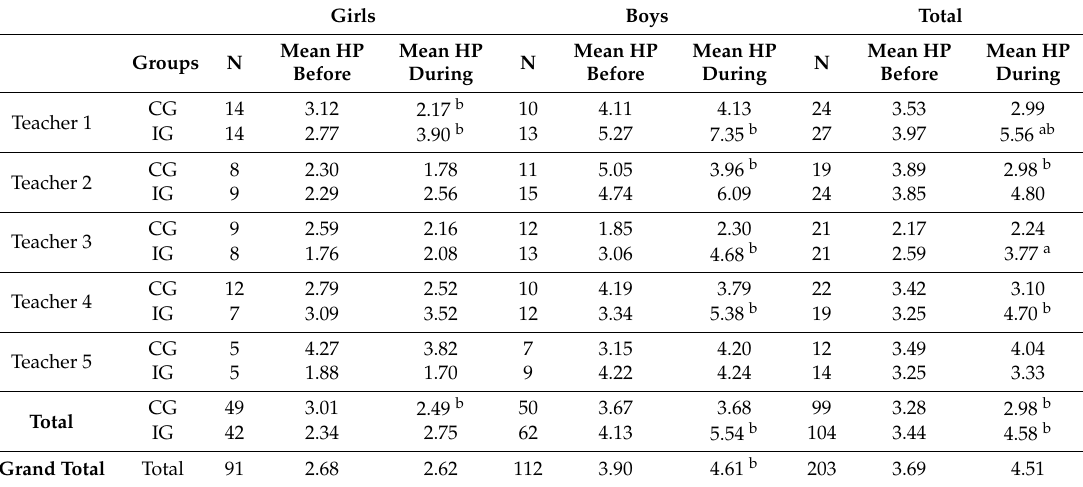
Table 2. PAP Participation Results Regarding each Teachers, CG / IG,